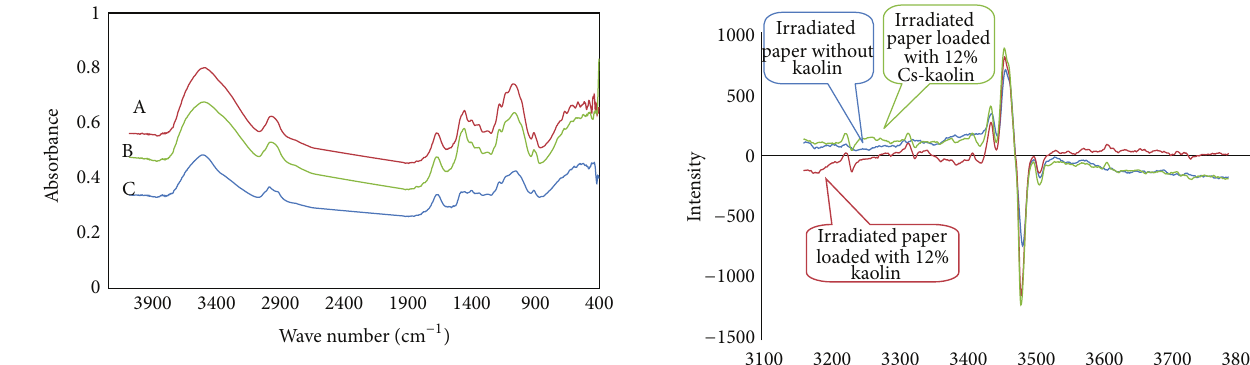
Figure 5: FTIR spectra for three 𝛾 -irradiated wood paper hand- sheets: A: paper loaded with 12% kaolin, B: paper loaded with 12% Cs-kaolin, and C: paper without kaolin.